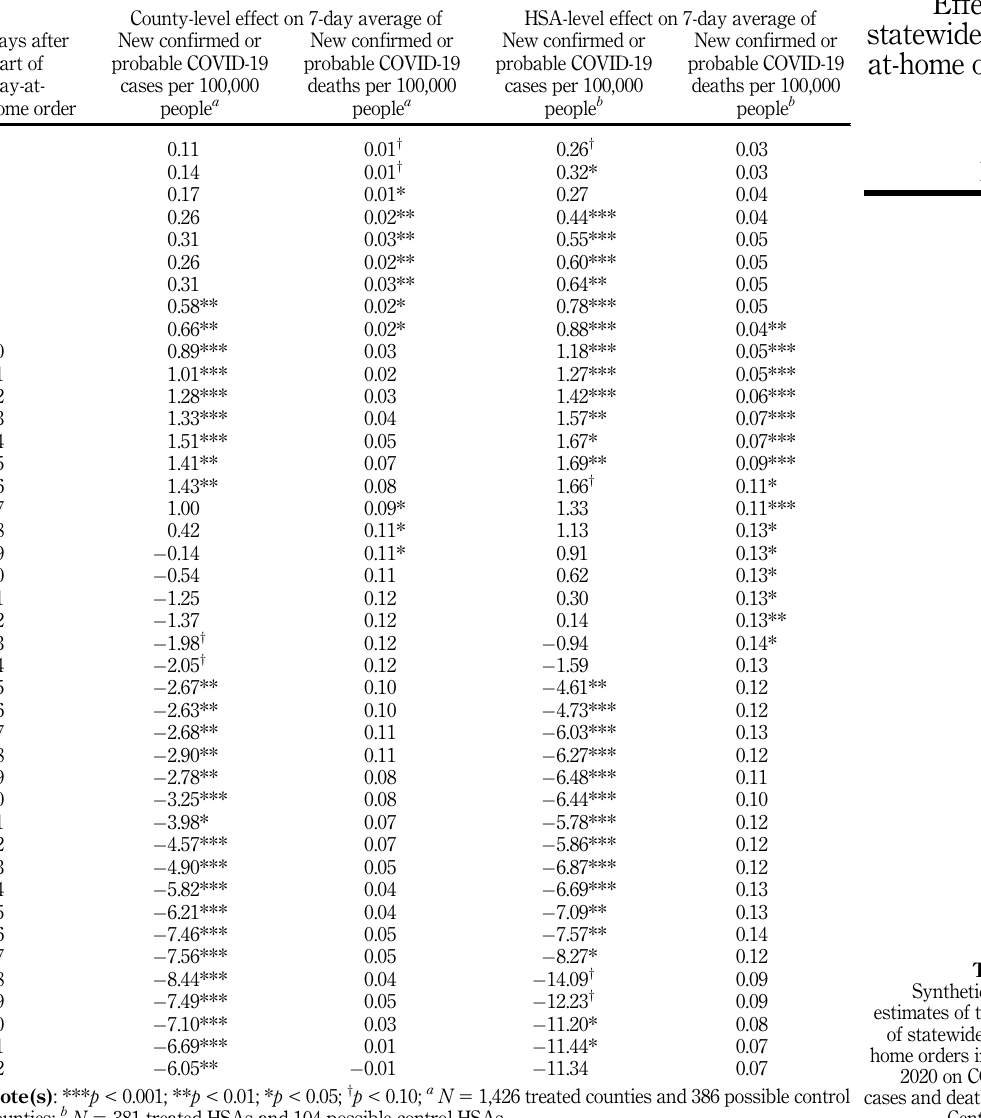
Table 3. Synthetic